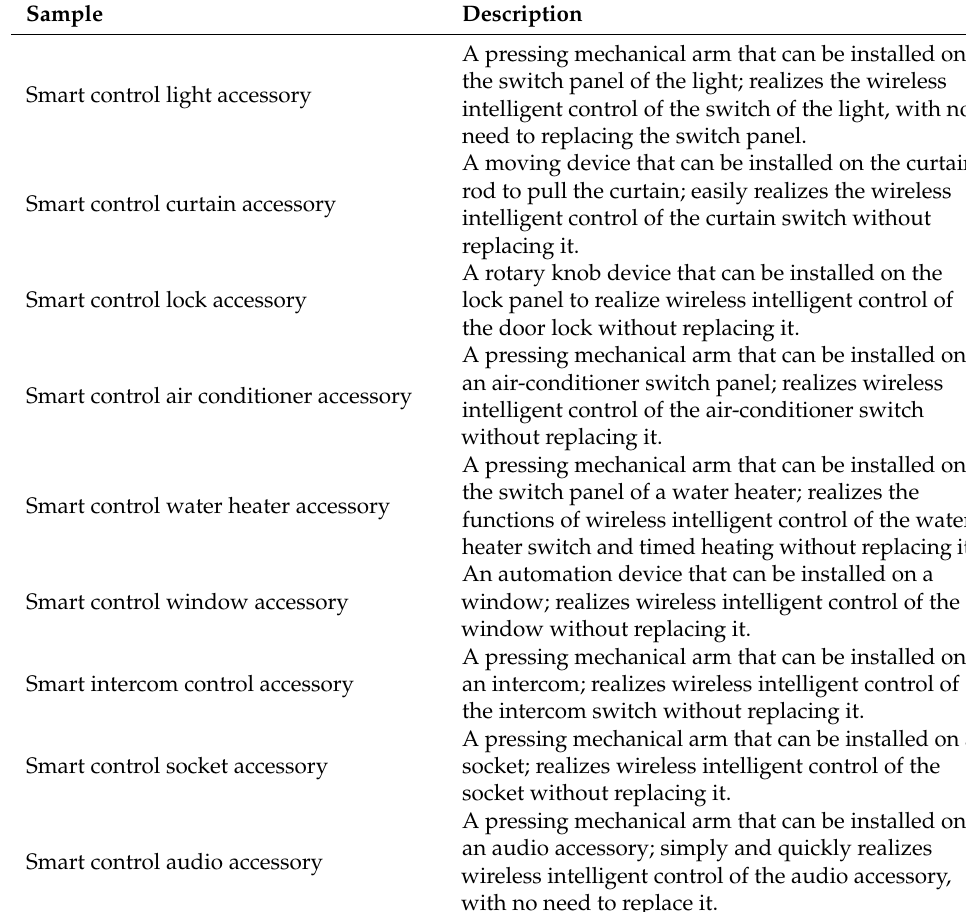
Table 3. GED samples for